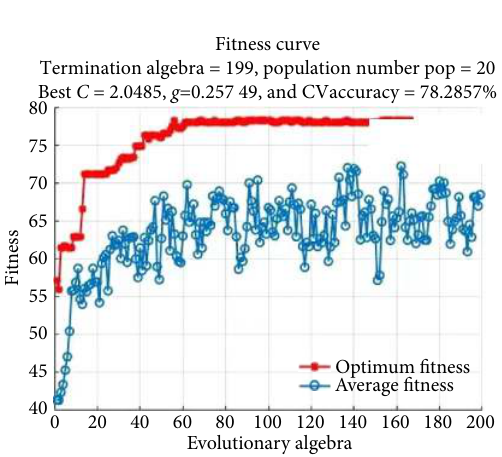
Fig. 10 GA parameter optimization